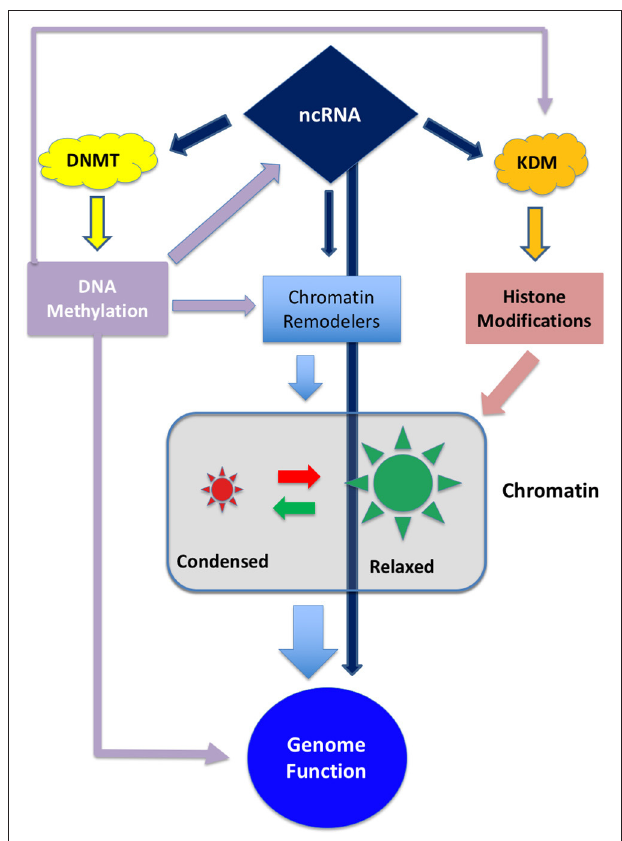
FIGURE 1 | Schematic representation of the interplay between the different epigenetic layers. ncRNA can directly influence genome activity by interfering with transcripts or, indirectly, by degrading transcripts involved in DNA methylation, histone modification or chromatin remodeling. On the other hand ncRNA can be epigenetically inactivated by DNA methylation (11, 12). DNA methylation can directly interfere with gene expression and, indirectly, can regulate the expression of chromatin and histone